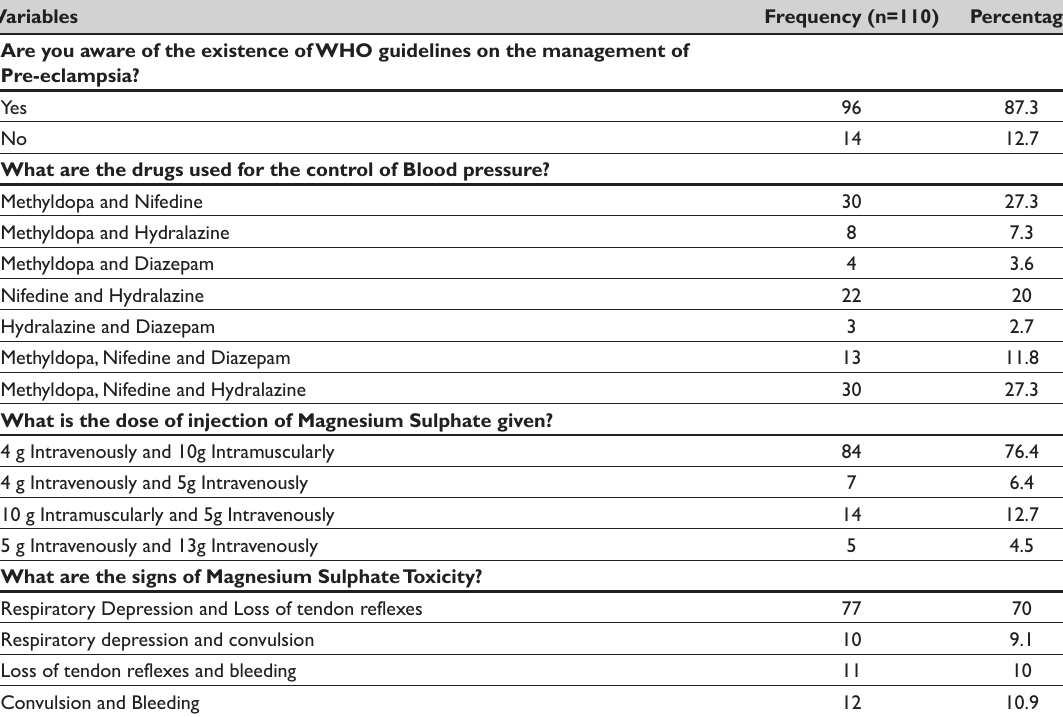
Table 5: Distribution of Management Practices for